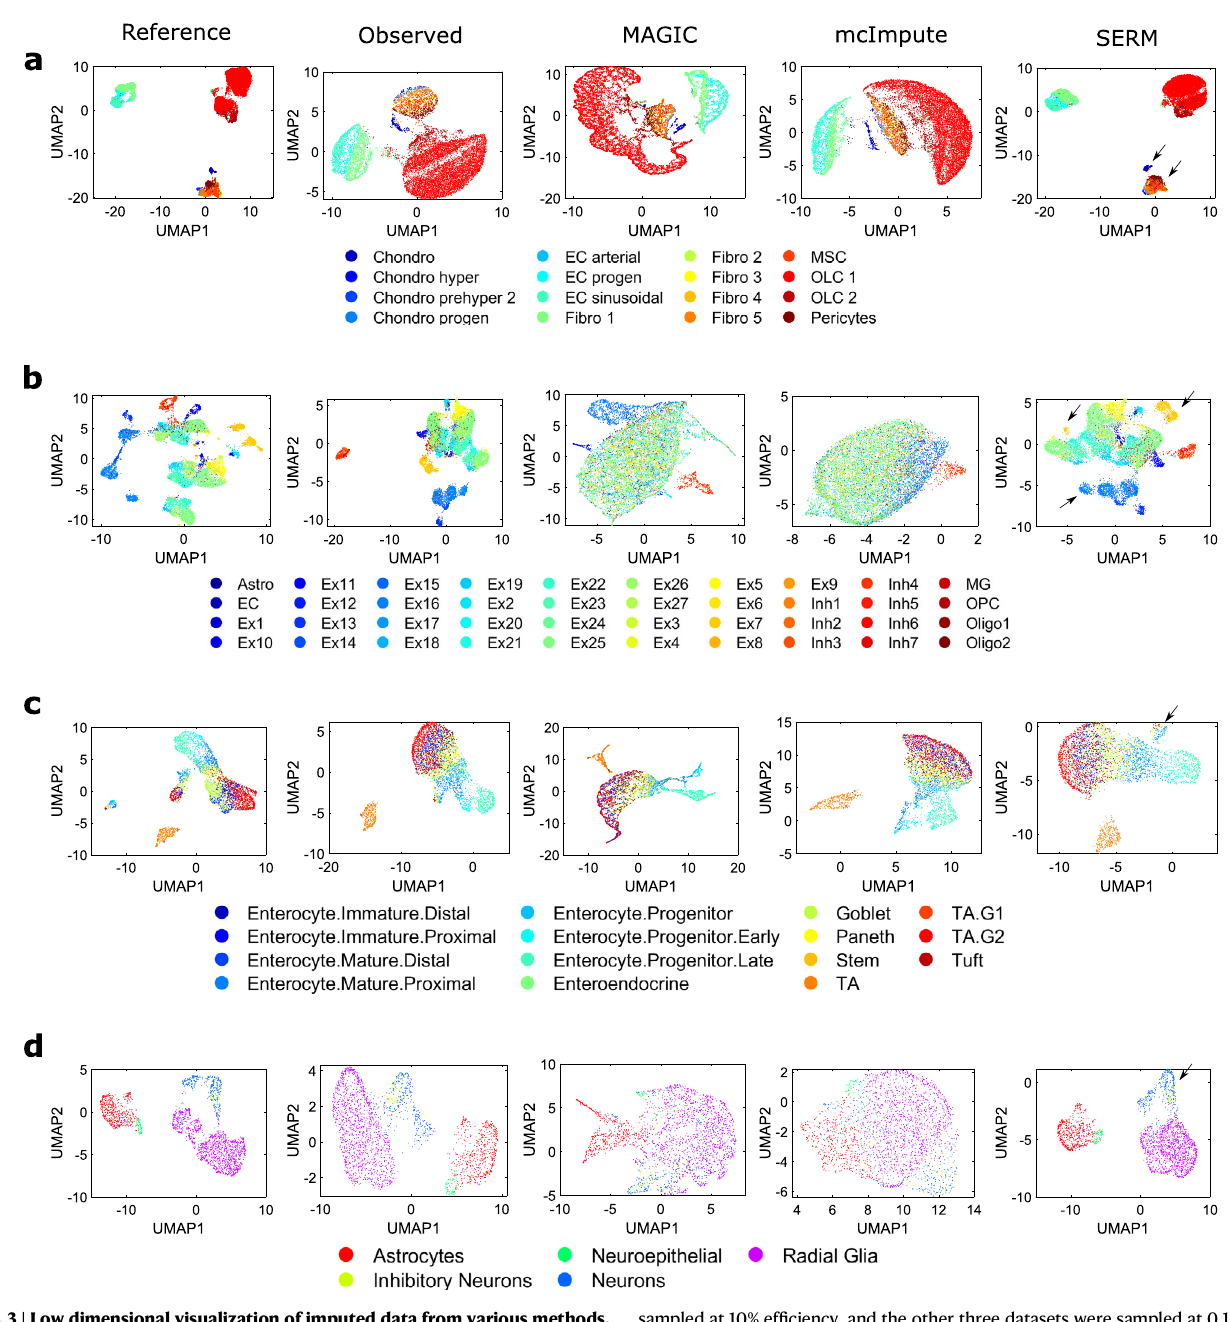
sampled at 10% ef fi ciency, and the other three datasets were sampled at 0.1% ef fi ciency. All the classes are better visualized in the SERM imputation. MAGIC and mcImpute distortthe data in many cases, whereasSERM retains the consistencyof the data intact in all cases. Source data are provided as a Source Data fi